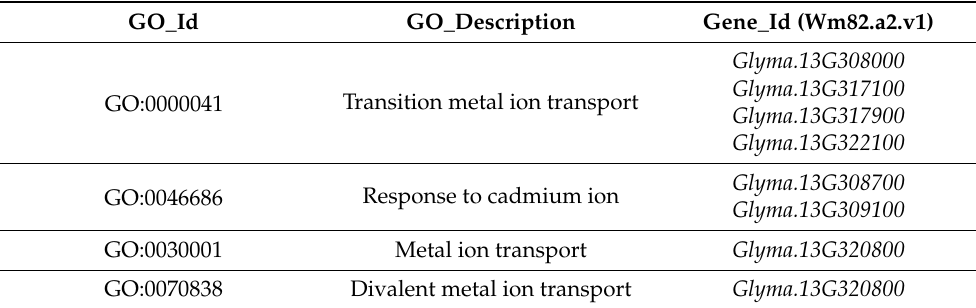
Table 1. The candidate genes identified within the Satt522-Satt218 region on Chr. 13, along with their corresponding GO terms of interest.